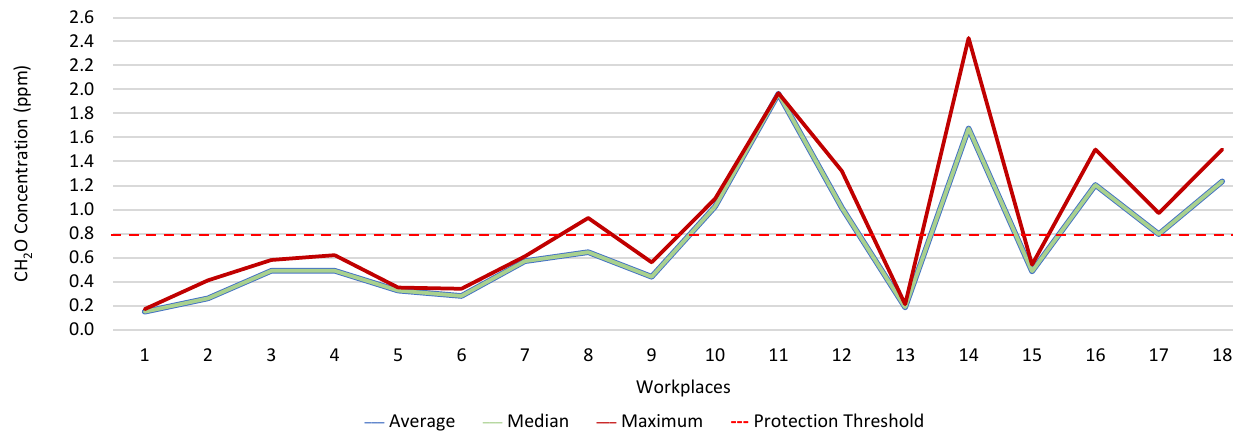
Figure 14. CH 2 O concentration (ppm) inside workplaces.